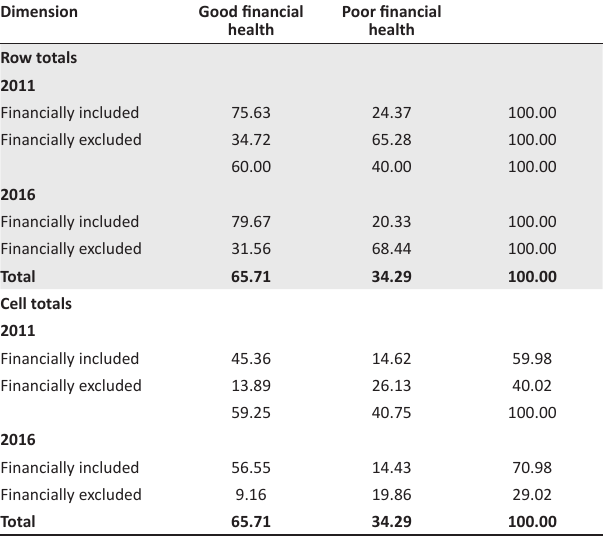
TABLE 4: 2 × 2 matrices on the relationship between financial inclusion and financial health statuses ( % ). Dimension Good financial